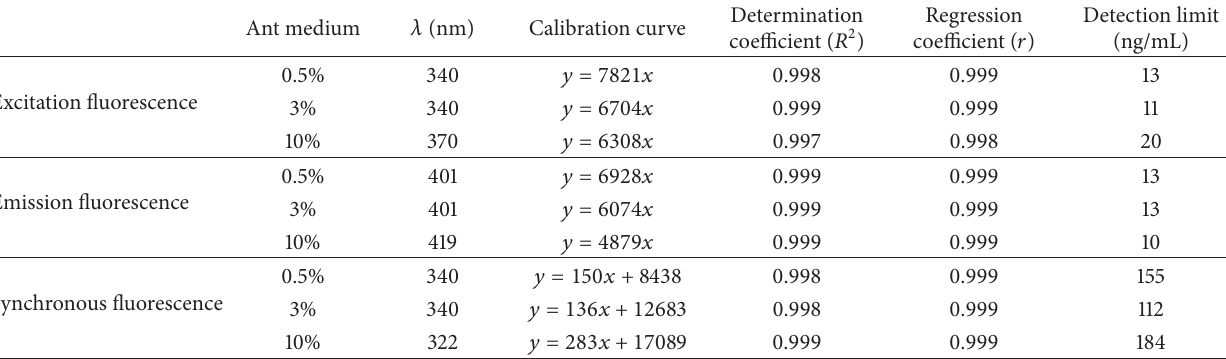
Table 1: Calibration curves and detection limits for the anthracene determination by excitation, emission, and fluorescence